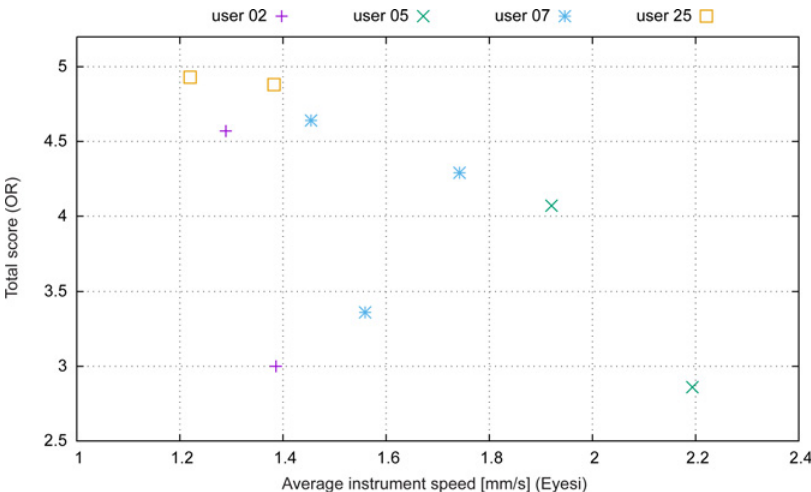
Fig 4. Average instrument speed (mm/s) in simulation in comparison to the performance in the operating